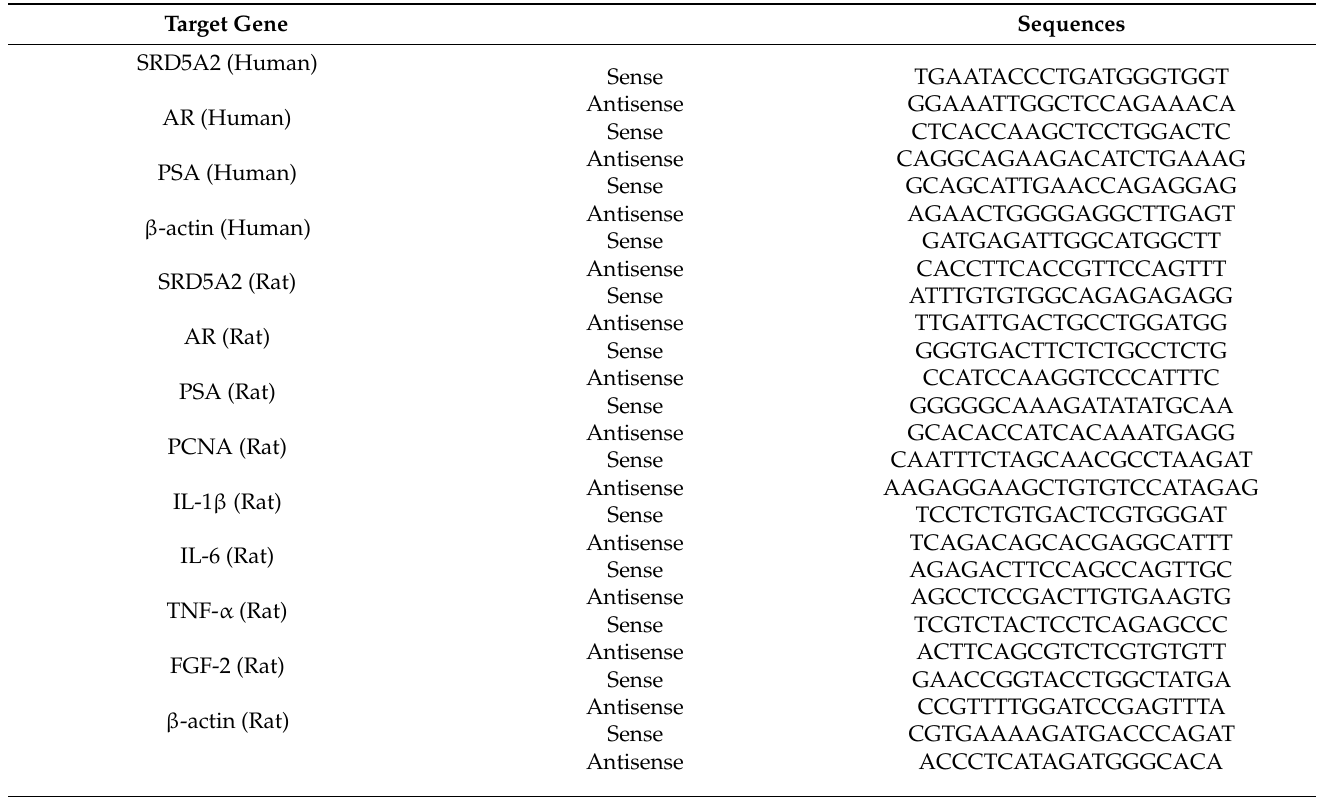
Table 1. Sequences of primers used for real-time